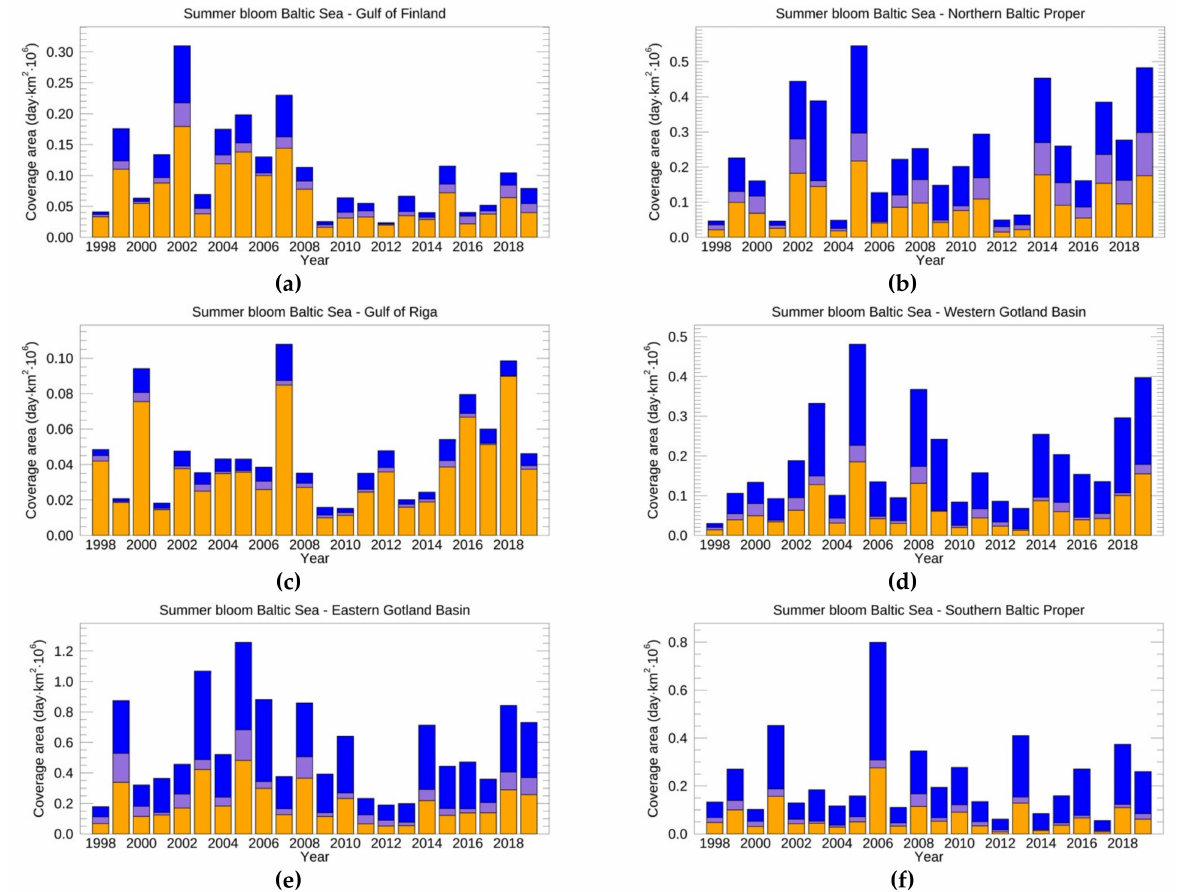
Figure 12. Summer bloom coverage (day · km 2 ) time series for the main sub-regions. Color legend as in Figure 10. ( a ) Gulf of Finland, ( b ) Northern Baltic Proper, ( c ) Gulf of Riga, ( d ) Western Gotland Basin, ( e ) Eastern Gotland Basin, and ( f ) Southern Baltic